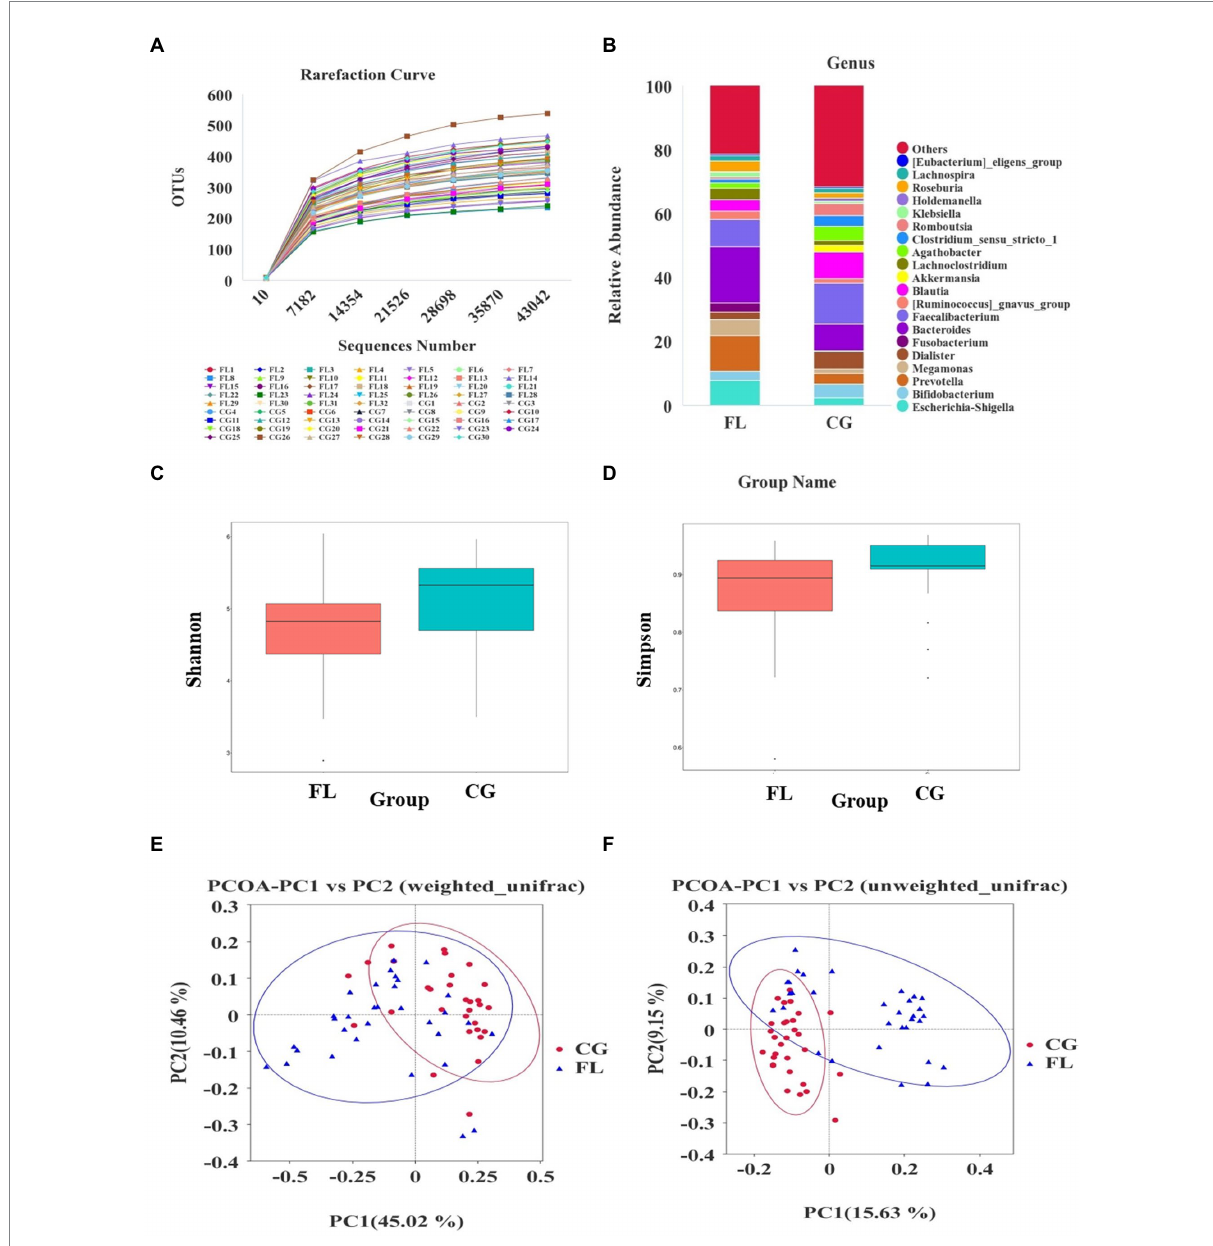
FIGURE 1 Altered gut microbiota diversity in metabolic associated fatty liver disease (MAFLD) patients. (A) Rarefaction curve based on OUT count in control groups (CGs) and MAFLD patients. (B) The relative abundance of dominant taxa at the genus level in each group. (C,D) The analysis results of alpha diversity indices (Shannon index and Simpson index), both p < 0.05. (E,F) Principal coordinates analysis (PCoA) analysis based on weighted unifrac distance and unweighted unifrac